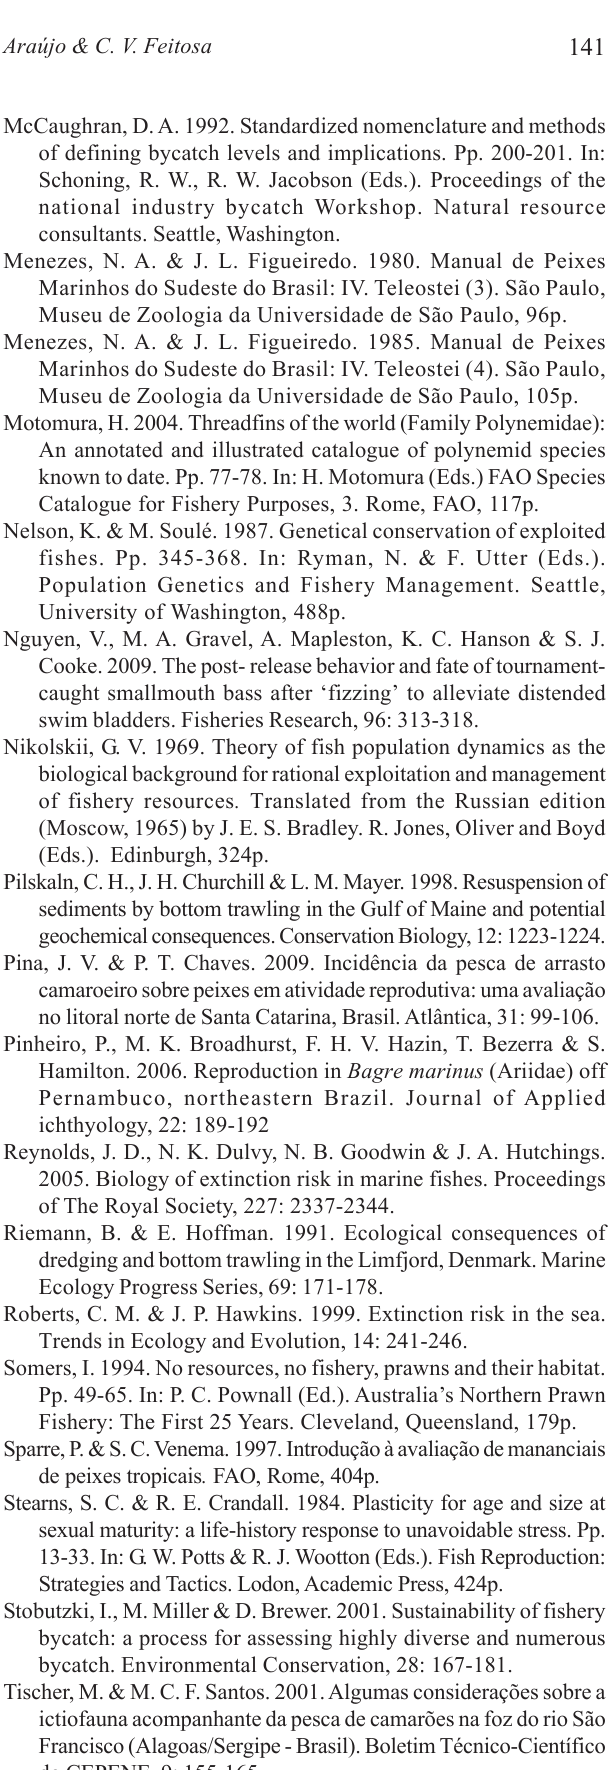
Figueiredo, J. L. & N. A. Menezes. 1978. Manual de Peixes Mari-